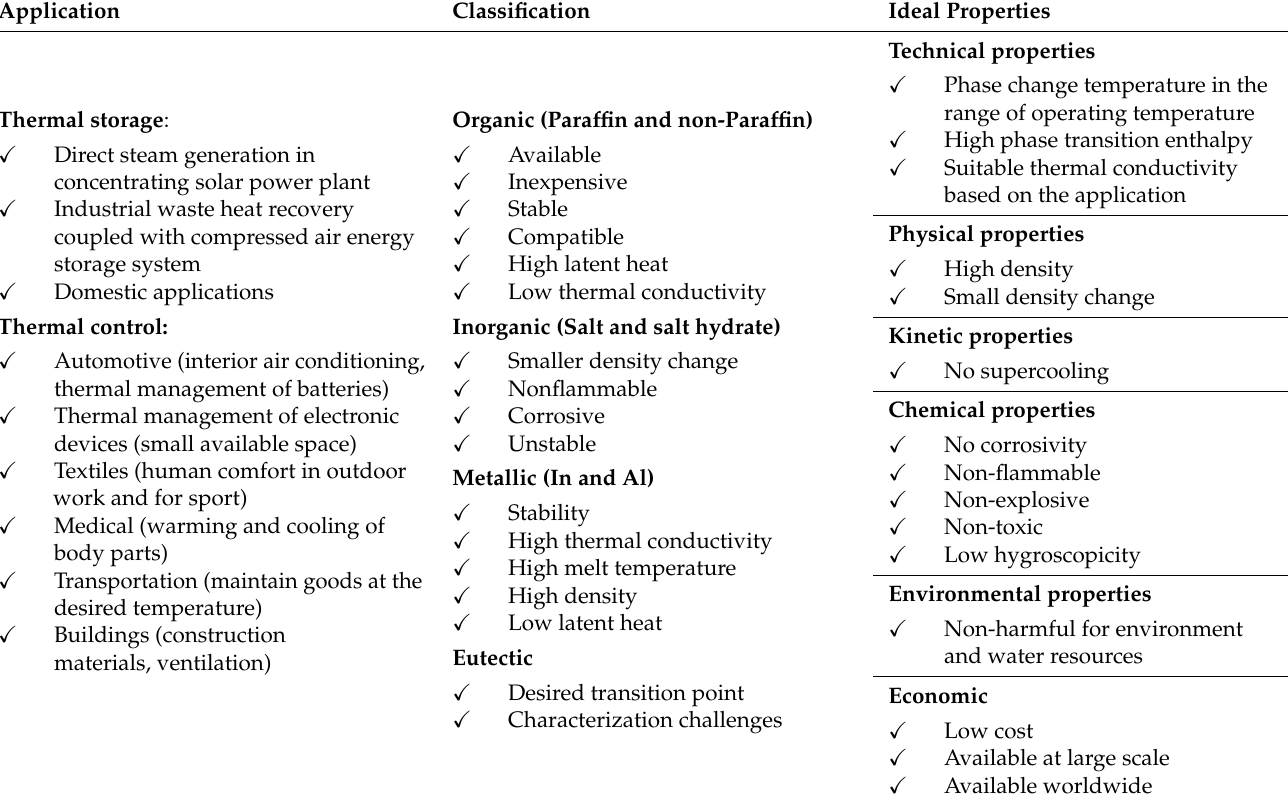
Table 1. PCM applications and their targeted optimal properties [2,13,16,17]. Classification Ideal